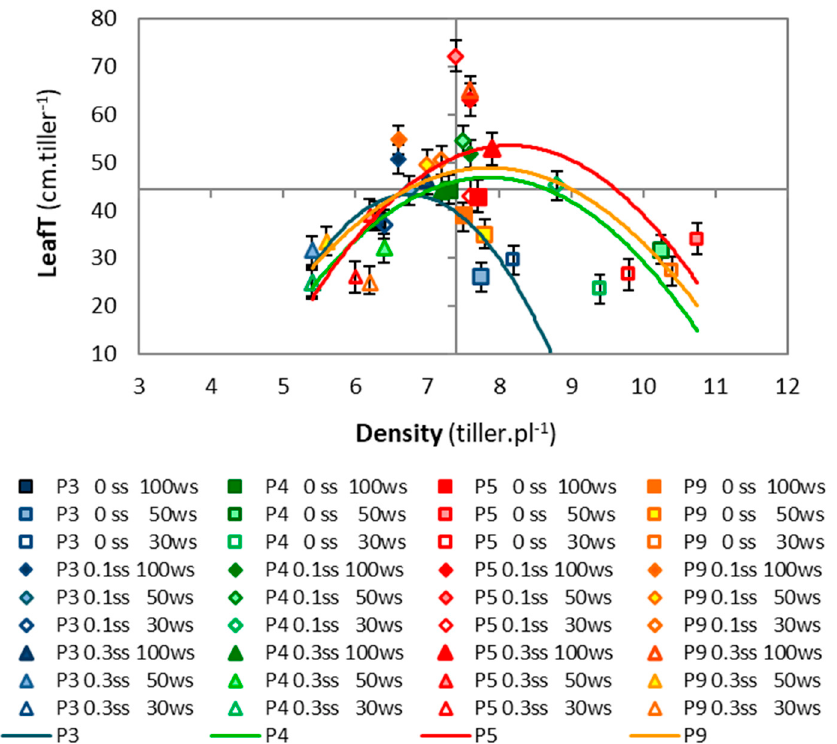
Figure 3. Relationship between Density and leaf length (LeafT) of four accessions (P3, P4, P5, P9) grown under three drought levels (0 WS, 50 WS, or 70 WS, corresponding to 100%, 50%, or 30% water capacity, respectively) combined with three salinity levels (0 SS, 0.1 SS, or 0.3 SS, corresponding to 0.0, 0.1, or 0.3 M NaCl, respectively). Data are means of five blocks ( n = 5). Bars indicate the means standard error. Colored lines show the behavior of each accession. P3: y = − 8.5x 2 + 114.4x − 342.6, R 2 = 0.76 *; P4: y= − 3.8x 2 + 59.9x − 188.3, R 2 = 0.62 *; P5: y= − 4.3x 2 + 69.1x − 227.98, R 2 = 0.46 ns; P9: y= − 3.4x 2 + 54.3x − 164.8, R 2 = 0.39 ns (ns p > 0.0500, * p < 0.0500).